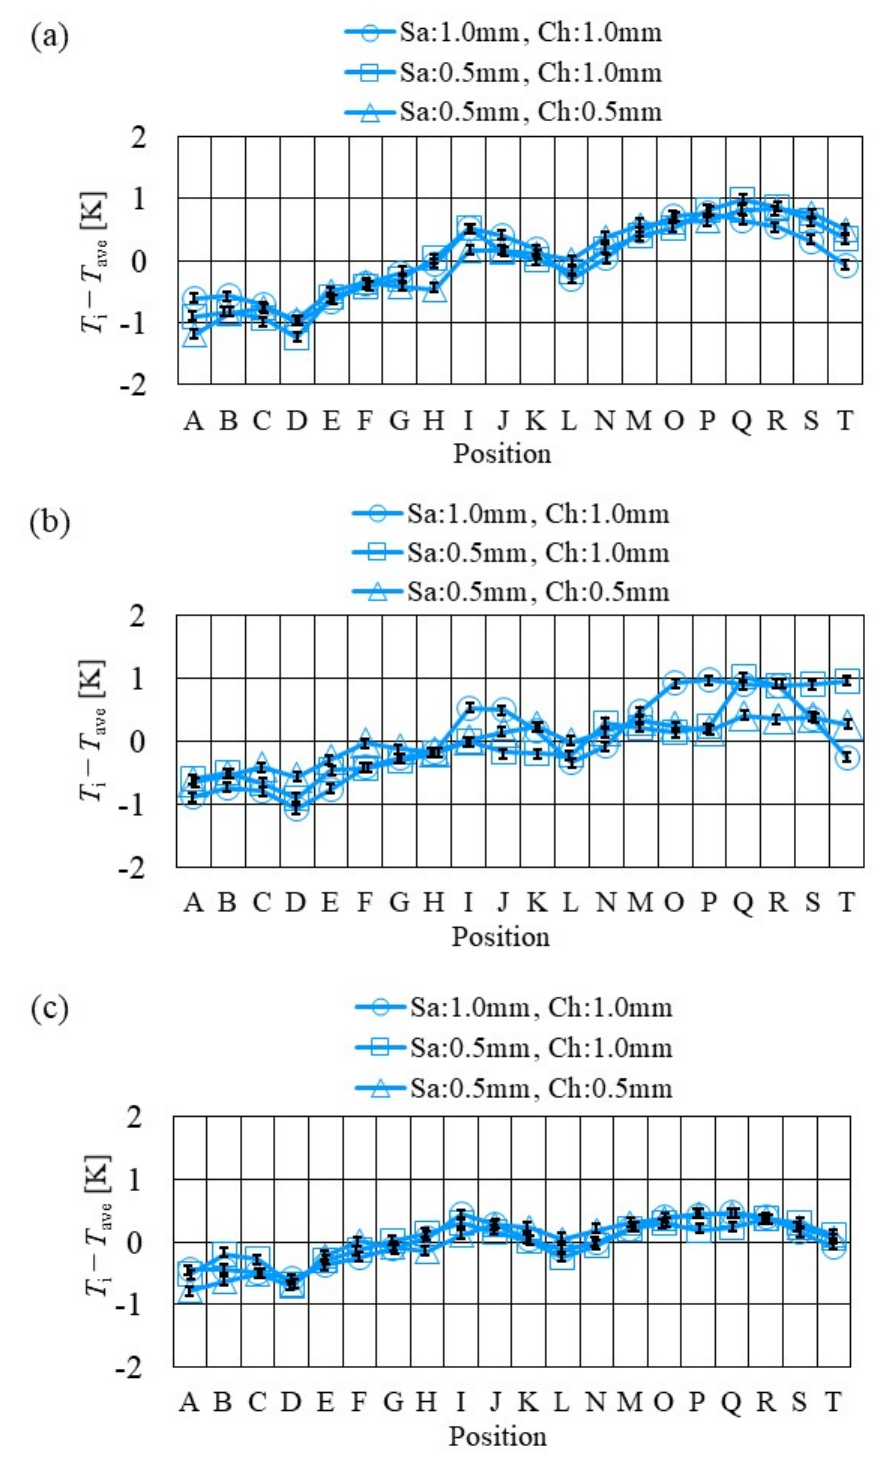
Figure 13. Comparison of the in-plane temperature distribution at the anode side among different separator thicknesses with A80%RH&C80%RH: ( a ) T init = 353 K; ( b ) T init = 363 K; ( c ) T init = 373 K.